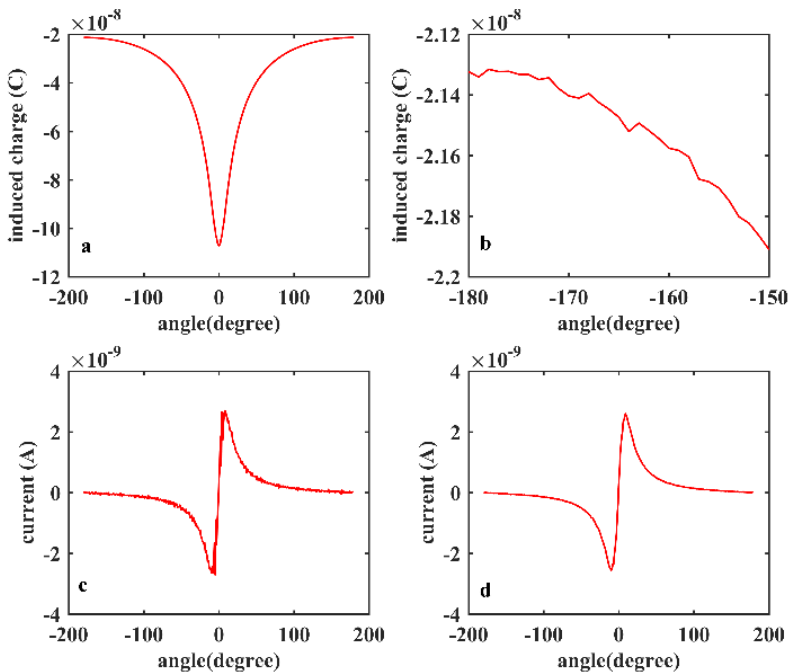
Figure 8. ( a ) Simulation result of induced charges; and ( b ) partial drawn of the induced charge. ( c ) Derivation of the induced charge; and ( d ) smoothed curve of the current.